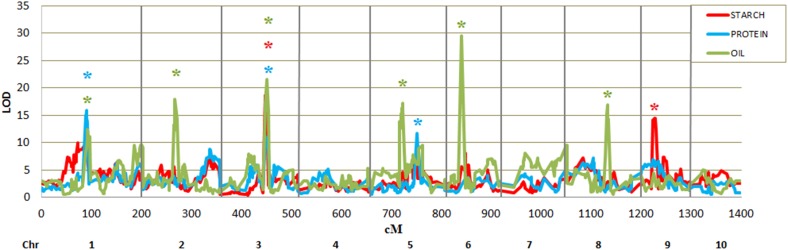
Joint-linkage QTL analysis for kernel starch, protein, and oil content in teosinte NILs. Horizontal units, cM; vertical units, log of odds (LOD). Asterisks indicate the presence of significant QTL for starch (red), protein (blue), or oil (green).